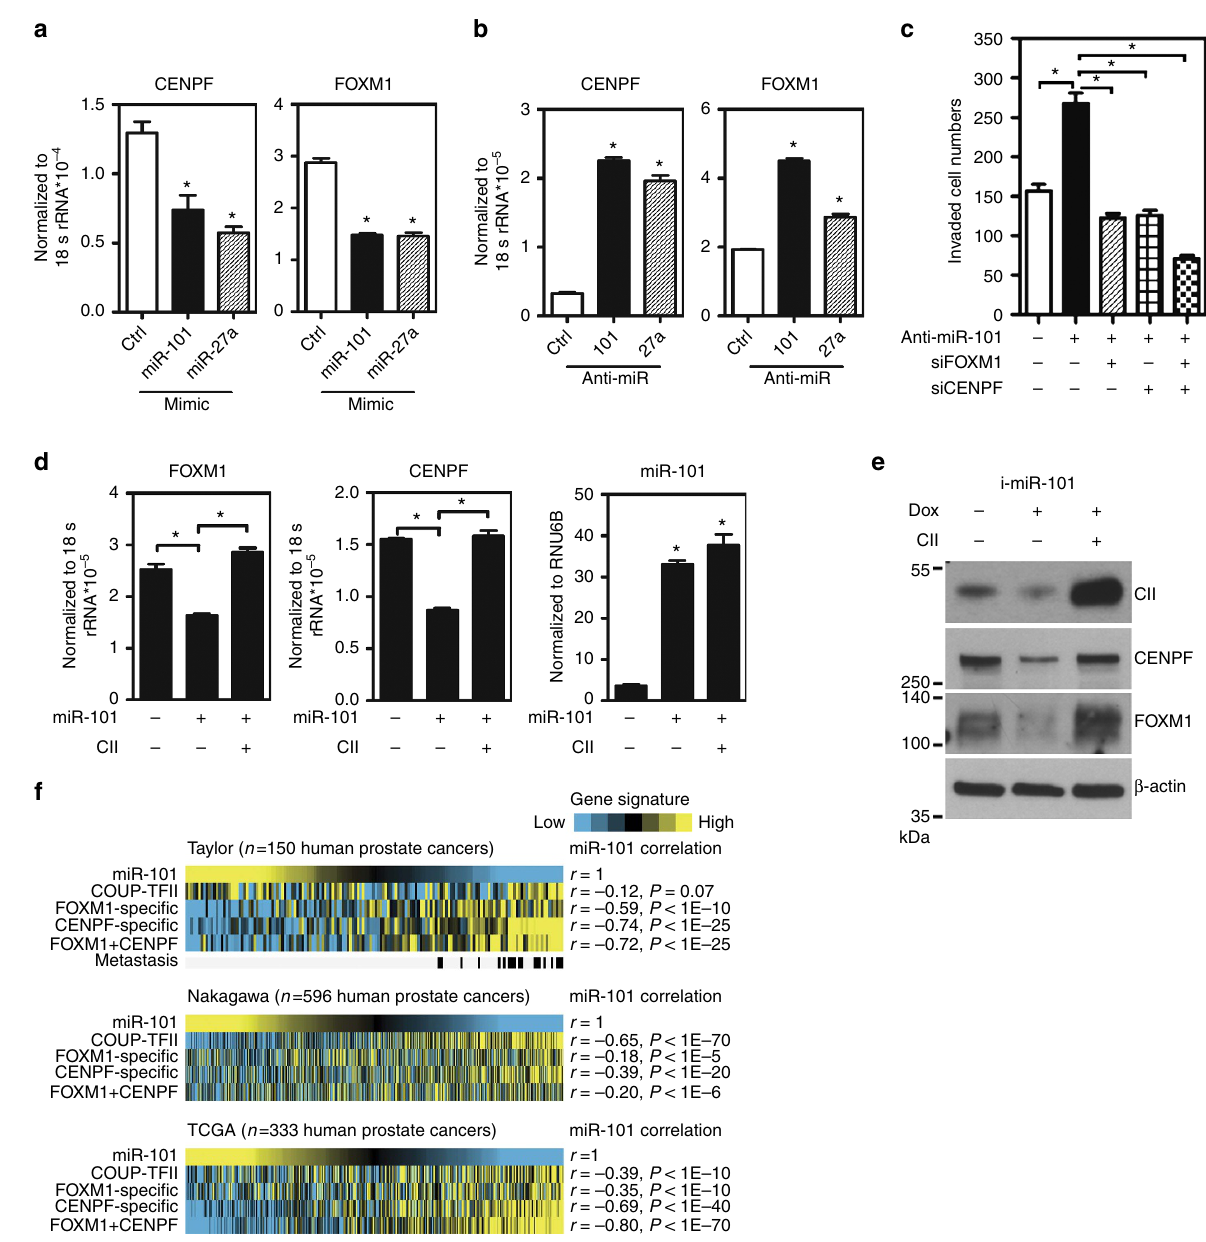
Figure 5 | miR-101-inhibited COUP-TFII leads to FOXM1 and CENPF downregulation in PCa. ( a , b ) Levels of CENPF and FOXM1 in LNCaP cells having overexpression of miR-101and miR-27a for 72h ( n ¼ 3) ( a ) and in 22RV-1 stably transfected with control, anti-miR-101 or miR-27a vectors ( n ¼ 3) ( b ). * P o 0.05 (two-sided Student’s t -test) compared with the control group. ( c ) 22RV-1 cells treated with 50nM miR-101 inhibitor and 25nM siRNA against FOXM1 or CENPF were plated into invasion chamber for 16h ( n ¼ 3). Invaded cell numbers were stained and counted. * P o 0.05 (two-sided Student’s t -test) compared with the control group. RT-qPCR ( d ) and representative western blot ( e ) shows the levels of FOXM1, CENPF and miR-101 from PC3 cells carrying an inducible miR-101 gene in the absence and presence of doxycycline ( n ¼ 3). Also shown in this figure is the rescue of FOM1 and CENPF expression when COUP-TFII is ectopically expressed for 96h. * P o 0.05 (two-sided Student’s t -test) ( f ) miR-101, COUP-TFII, FOXM1, CENPF and FOXM1- CENPF co-regulated gene signatures were analysed in primary PCa specimens for three different expression data sets of human tumours. Yellow, high- signature scoring in prostate tumour specimens, is indicative of high manifestation of associated transcriptional patterns; blue, equals low-signature scoring. Correlation between miR-101 signature scores and scores for other signatures were tested by Pearson’s